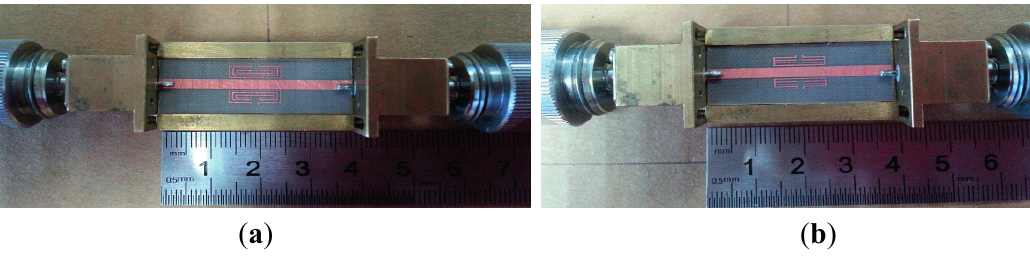
with (inset) E-field at 5 GHz for ( a ) aligned-gap; 21